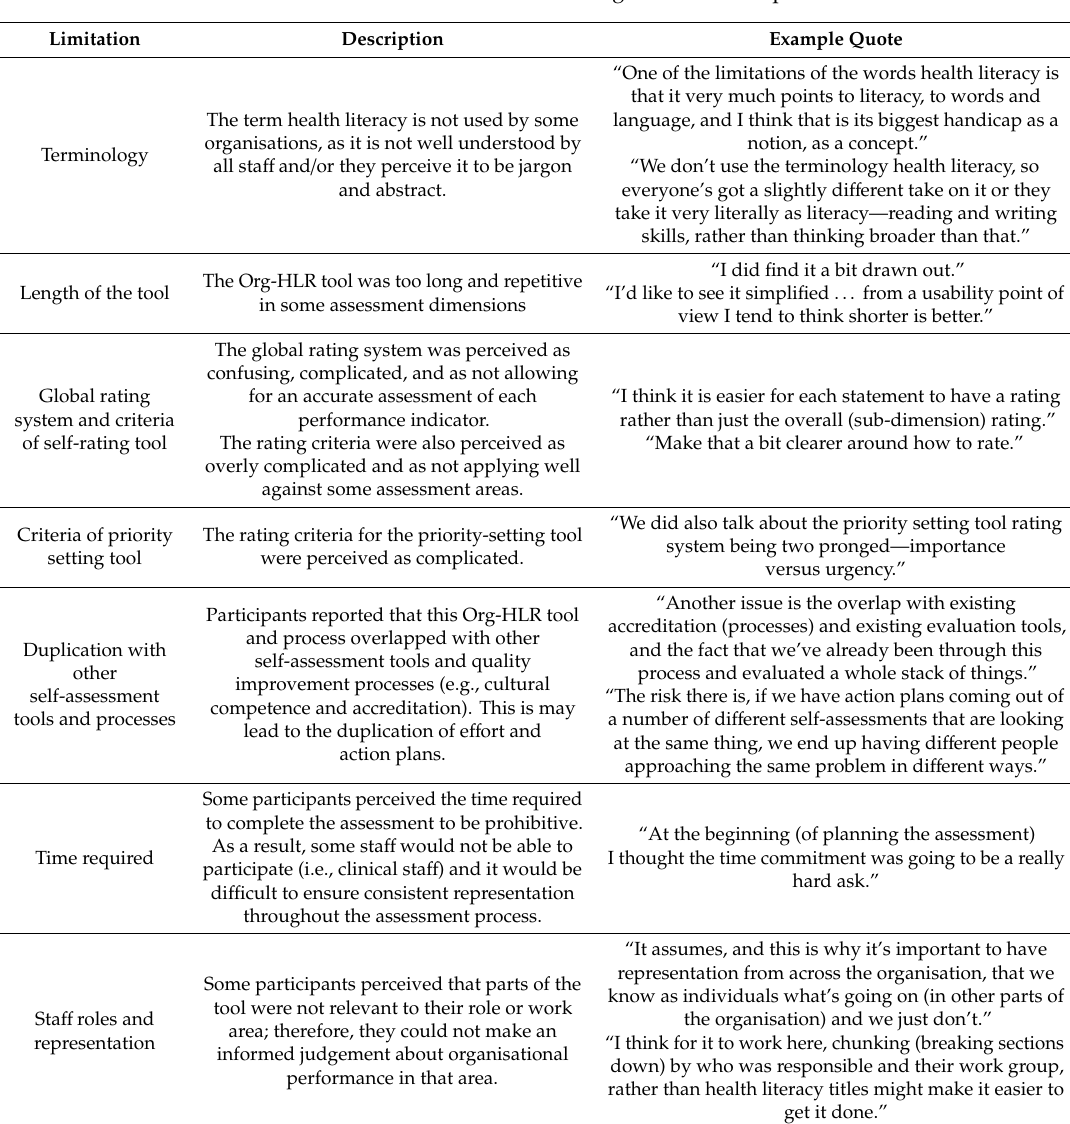
Table 5. Perceived limitations of the Org-HLR tool and